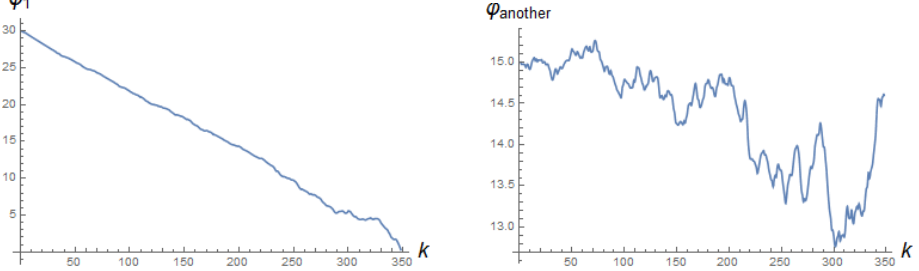
Figure 6 . The evolution of trajectories for dimension 20. In this case we choose the sine activation function and we set (cid:11) = 6000, (cid:12) = 100, ! = 1, A = 10 (cid:0) 15 and h = 100. And also we set V rand = A h ( ’ 1 ; ’ i 6 =1 ). We show the trajectories ’ 1 ( k ) (left) as a function of time step k for in(cid:13)aton, and ’ another ( k ) (left) for another light